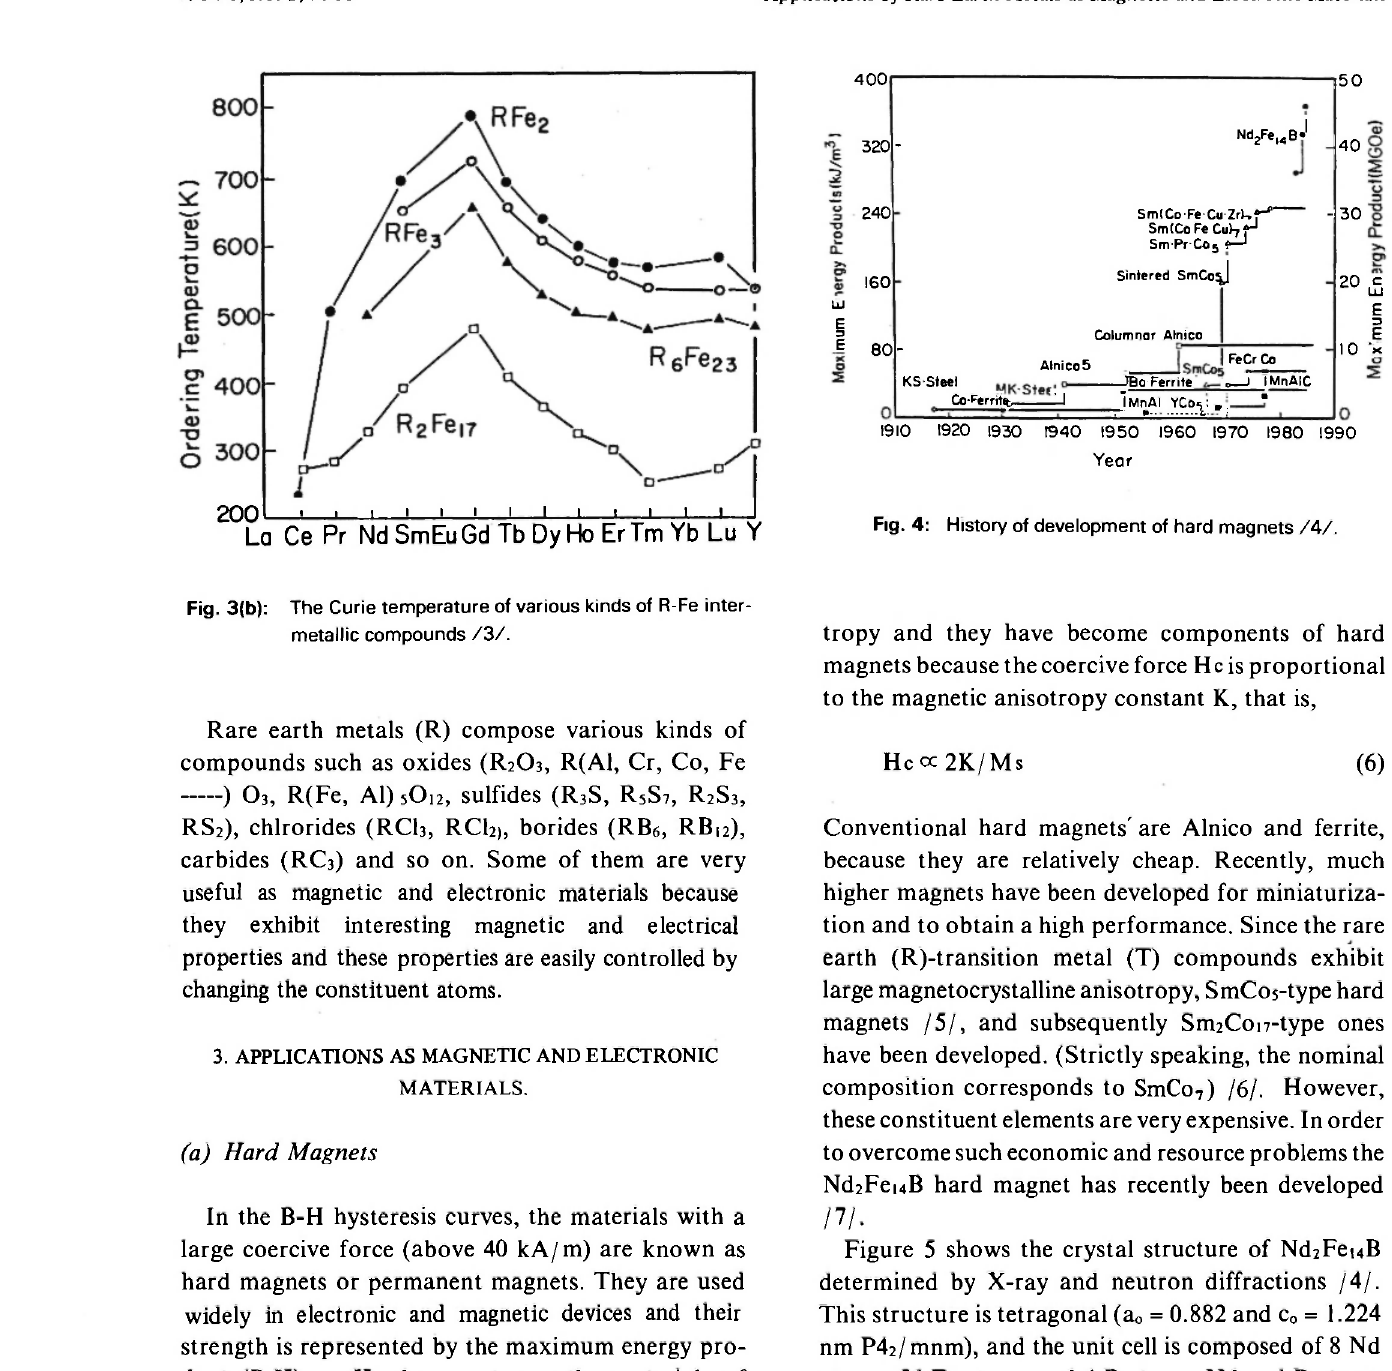
F, 9 4: H,stor V of development of hard magnets /4/.